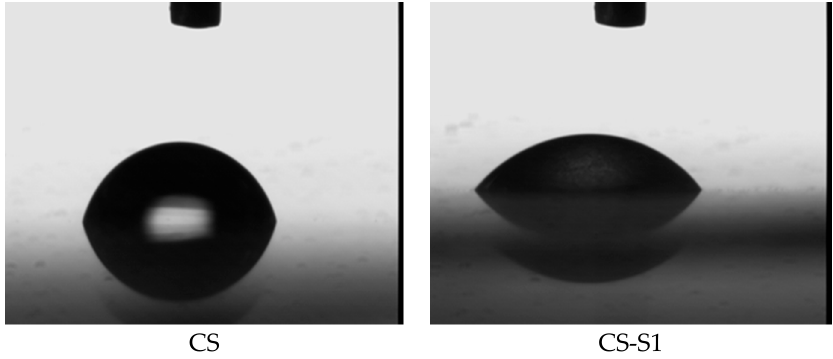
Figure 4. Images obtained during the measurements (time zero): chitosan (CS) and CS-sulfamethoxydiazine (CS-S1) films.